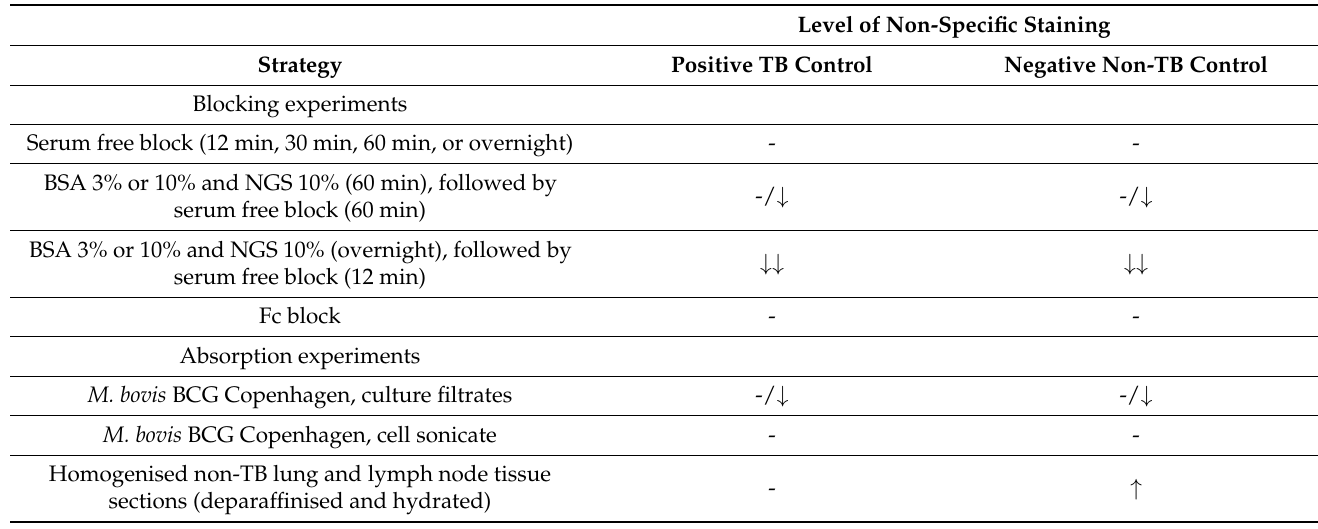
Table 2. Strategies employed to reduce non-specific staining in immunohistochemistry with the new polyclonal antibody. Level of Non-Specific Staining Strategy Positive TB Control Negative Non-TB Control Blocking